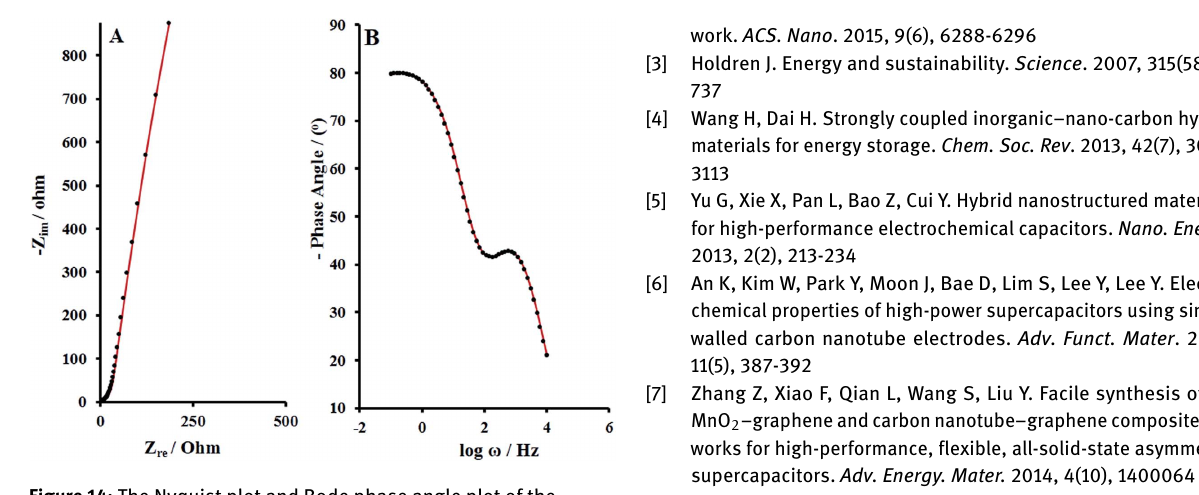
Figure 14: The Nyquist plot and Bode phase angle plot of the TRGO/PMF nanocomposite. A was the Nyquist plot and B was the Bode phase angle plot. EIS studies were performed in the frequency range from 0.1 to 100 kHz and